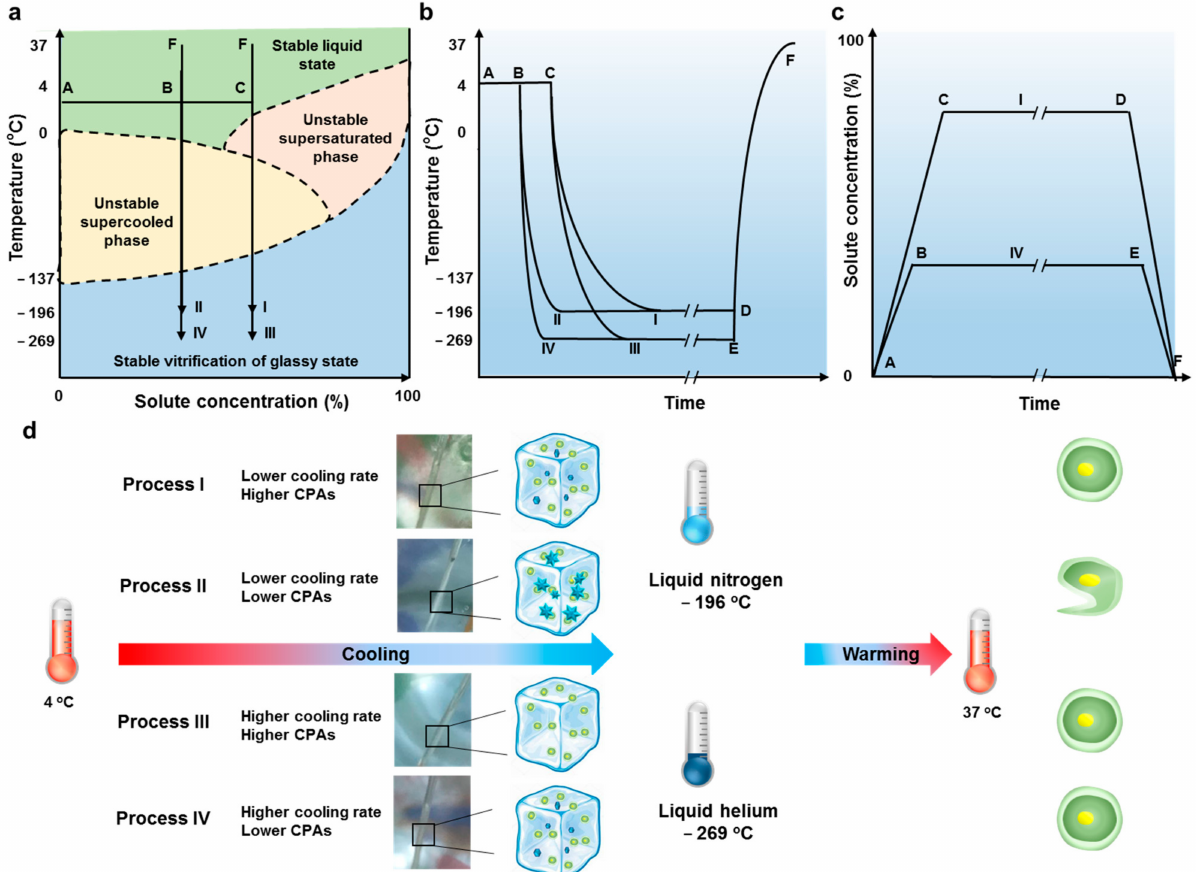
Figure 4. Thermodynamic process analysis of cell vitrification. ( a ) Phase diagram of biospecimens processed using different vitrification methods during cooling processes. Arrows indicate the direction of the preservation process. ( b ) Thermal time course. The latent heat of phase transitions was neglected both for cooling (heat release) and warming (heat absorption) processes. ( c ) Time course of the solute concentration. I was the optimal process for LN 2 as the cryogen, IV was the optimal process for LHe. Long-term storage was presented by ‘//’ in ( b , c ). ( d ) Illustration for cell vitrification using liquid nitrogen or liquid helium as